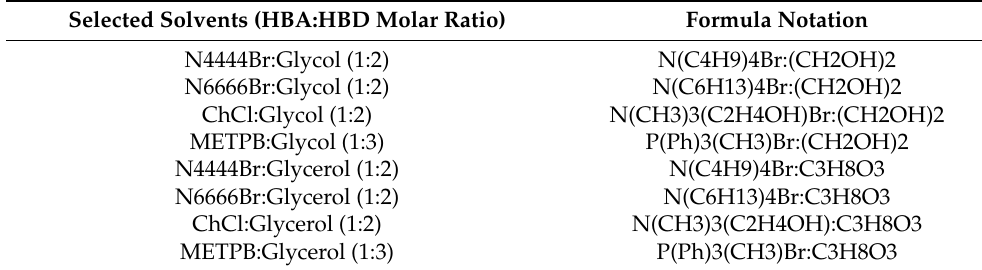
Table 1. Selected DES for Initial COSMO Model